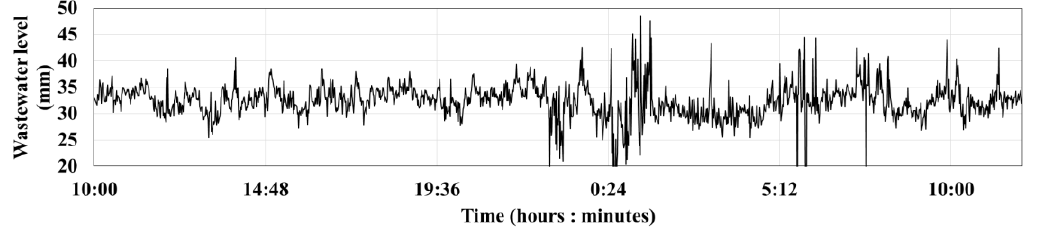
Figure 8. Wastewater level determined using method 3.